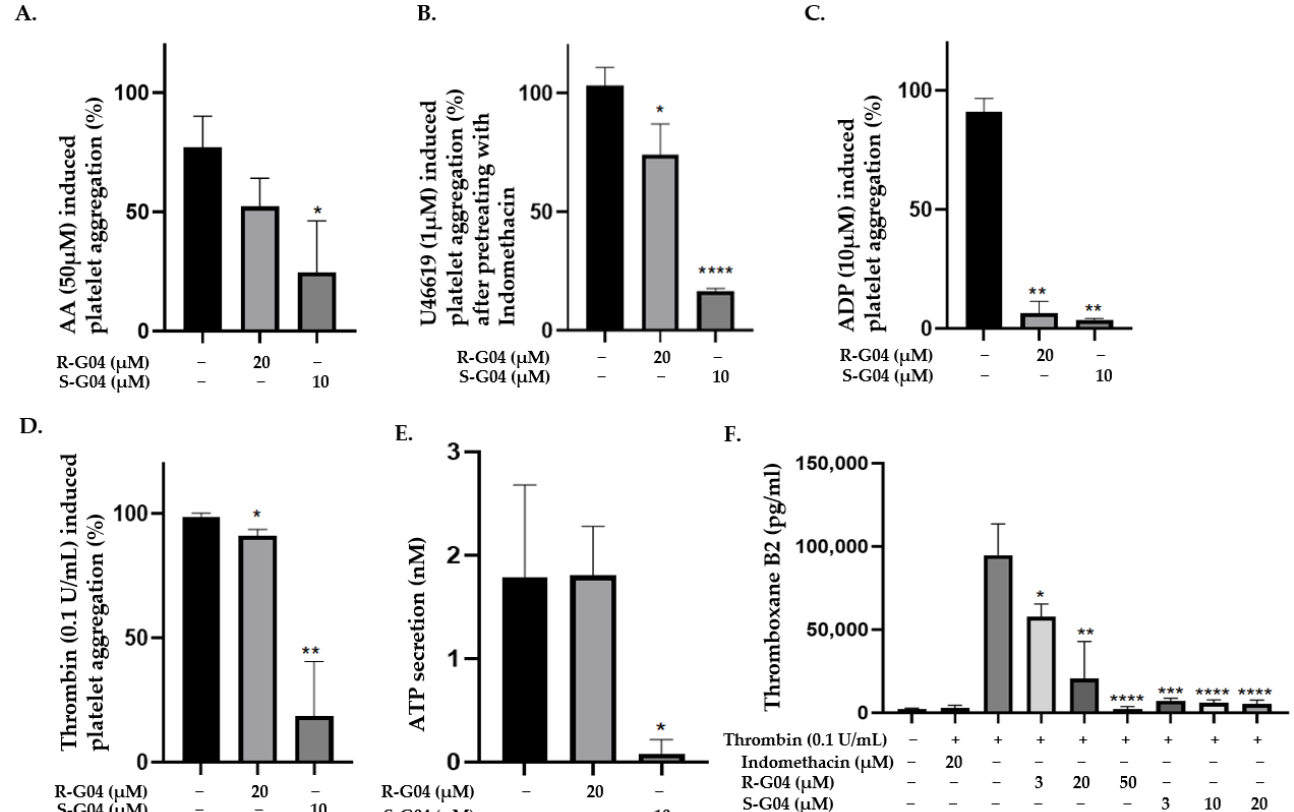
Figure 7. S-G04, but not R-G04, significantly inhibits Arachidonic Acid-, U46619-, and Thrombin- induced platelet aggregation and ATP secretion, while both R-G04 and S-G04 inhibit ADP-induced platelet aggregation and Thromboxane B2 (TxB2) secretion . ( A – D ) Washed human platelets were pre-incubated with 10 µM S-G04 or 20 µM R-G04 for 2 min before being stimulated with Arachidonic Acid (AA), U46619, ADP, or Thrombin. The % platelet aggregation was measured 5 min after agonist stimulation. (E) Washed human platelets were pre-incubated with 10 µM S-G04 or 20 µM R-G04 for 2 min and with Chrono-lume ® for 30 s at 37 °C before being stimulated with 0.1 U/mL Thrombin. (F) Washed human platelets were pre-incubated with different concentrations of R-G04 or S-G04 or with 20 µM Indomethacin for 2 min before being stimulated with Thrombin. TxB2 for- mation was determined using a TxB2 ELISA kit. The differences among DMSO, R-G04, and S-G04 were analyzed using t -test, and the results are shown as means ± SDs of three independent experi- ments. (* p < 0.05, ** p < 0.01, *** p < 0.001, and **** p < 0.0001).